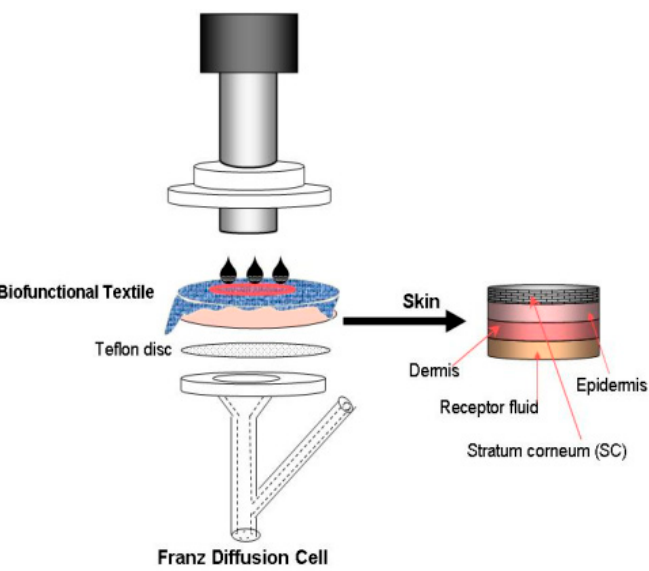
Figure 1. Diagram of in vitro percutaneous absorption experiments.